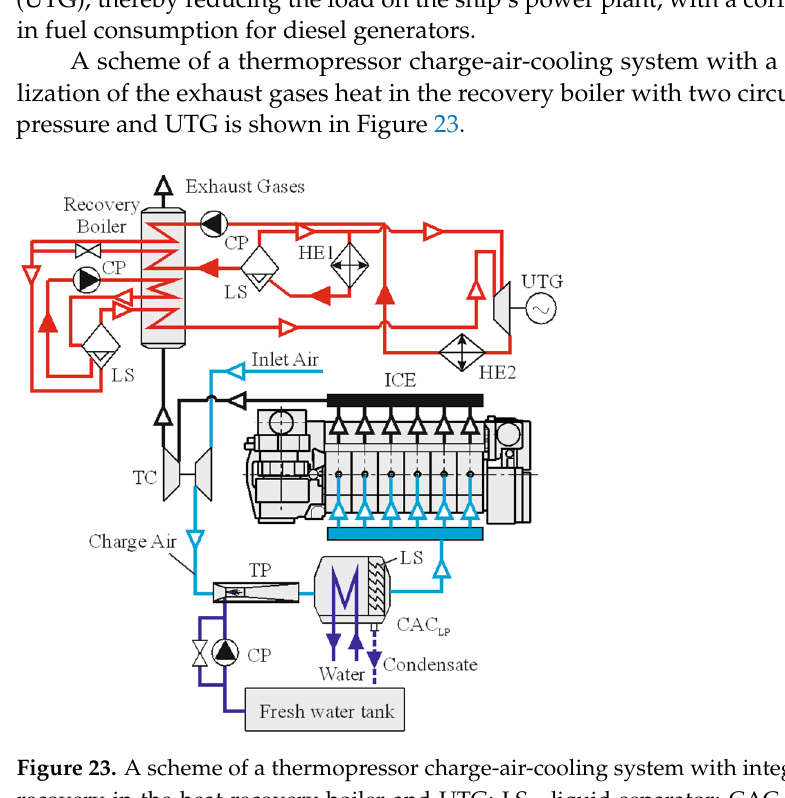
Figure 24. Dependences of the increase in UTG power Δ N utg , increase in steam consumption pro- duced in the recovery boiler of two pressures Δ D utg at different total pressure increase ε c . tp on the inlet air temperature T in . It was proposed to install two MAN B&W 7L16/24 diesel generators on the ship with a rated power N e = 770 kW and a specific fuel consumption g e = 195 g/(kW ∙ h). Reducing the load on the ship power plant when the UTG is used (Figure 26) reduces the specific fuel consumption up to Δ g e = 4–7 g/(kW ∙ h), while temporarily reducing the fuel consump- tion Δ G e = 10–18 kg/h (240– 430 kg/day). The analysis of economic feasibility shows that the reduction in fuel consumption per voyage within 28 days will be Δ G e . v = 7–12 tons. Taking into account the annual operation of the vessel, the reduction in fuel consumption per year will be Δ G e . y = 90–150 tons (Figure 27). 4050607080